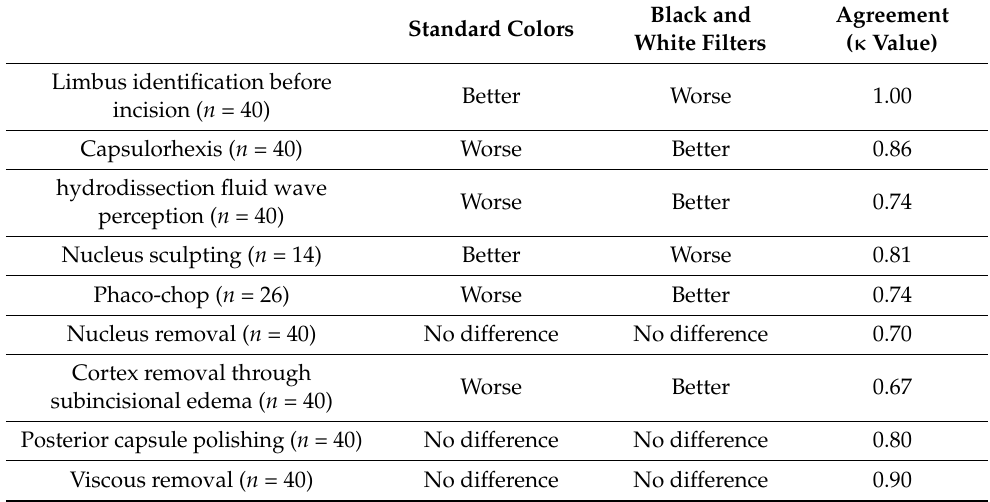
Table 1. Subjective evaluation and agreement between two surgeon observers assessing for visualiza- tion quality between black and white filter and standard colors at each step of cataract surgery.